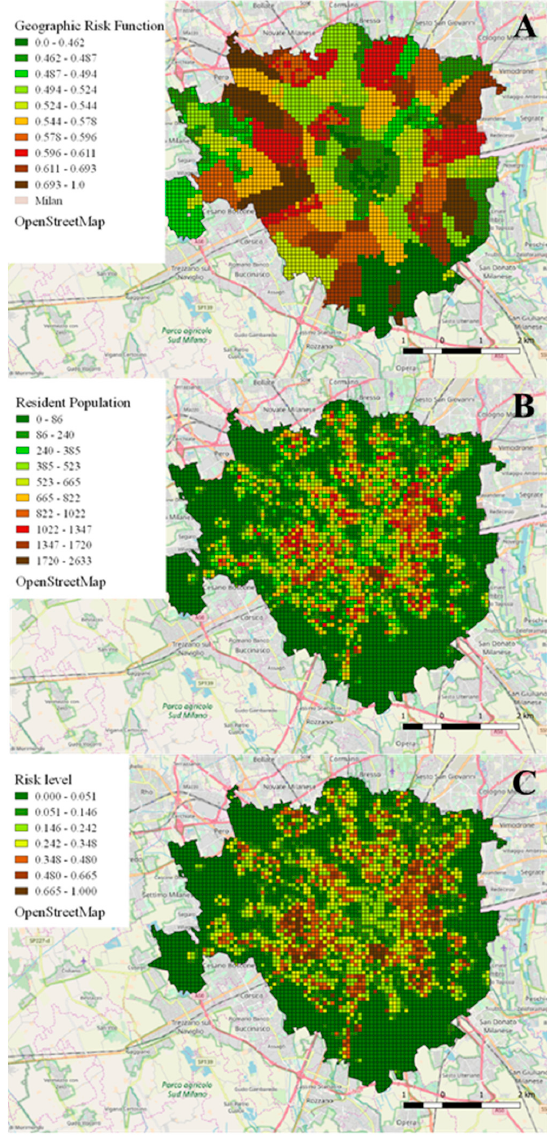
Figure 3. Schematization of the implementation of the geographic risk function. Panel A : The purely geographic risk estimator (scaled in the range 0 to 1) is computed for each 200 × 200 m cell in which the city territory was divided. Panel B : Number of estimated residents for each cell. Panel C : Their product, where the geographic risk estimator was applied as a weight, providing a final risk function estimating Out-of-Hospital Cardiac Arrest (OHCA) occurrence probability (scaled in the range 0 to 1).